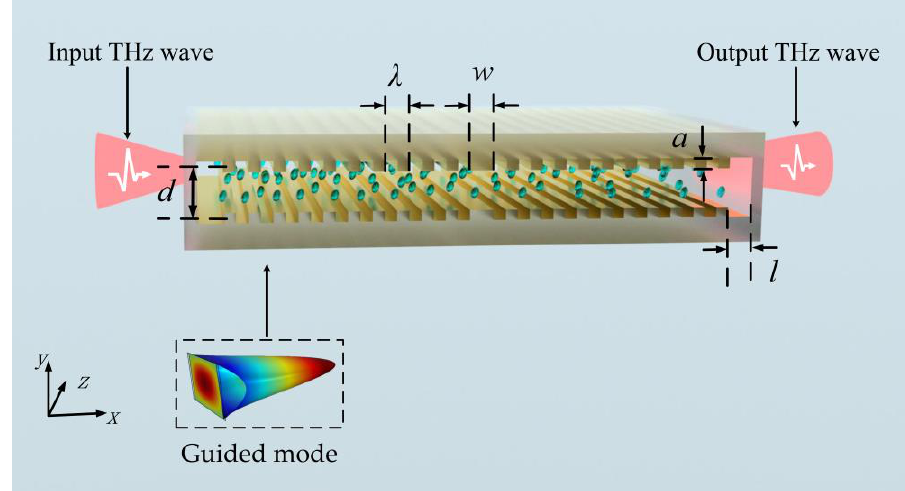
Figure 1. Structure of the proposed electrically tunable THz filter. A layer of gold is coated on the corrugated HDPE substrates to form the wall of waveguides. The big blue dots denote the filled LCs, and the THz radiation passes through the slit from left to right along x -axis. The inset depicts the cross-sectional view of the guided mode.